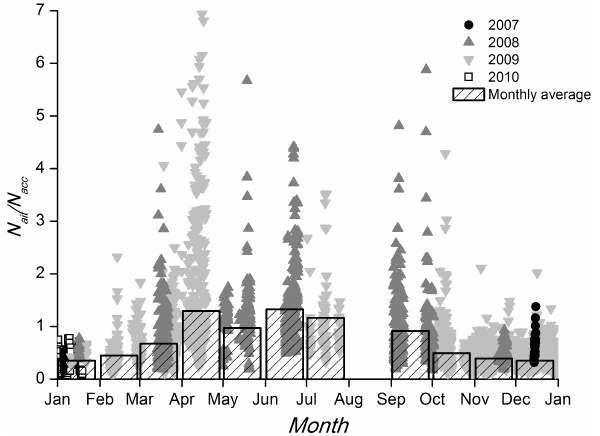
Fig. 7. Ratio of Aitken and accumulation mode particles, N ait /N acc . Each point is 1h average, bars correspond to a monthly average from the full data set.